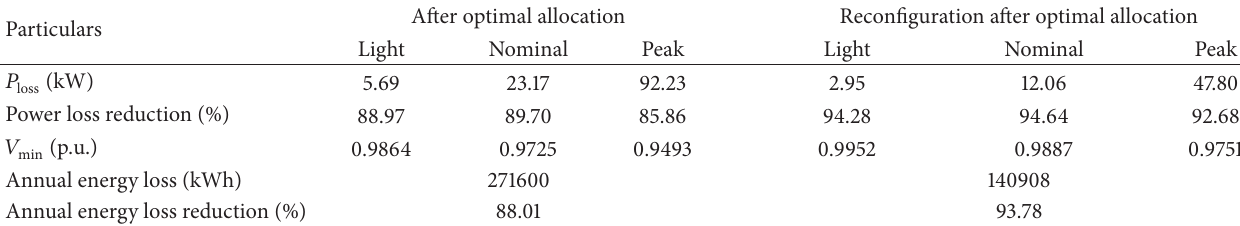
Table 4: Distribution network performance using the proposed